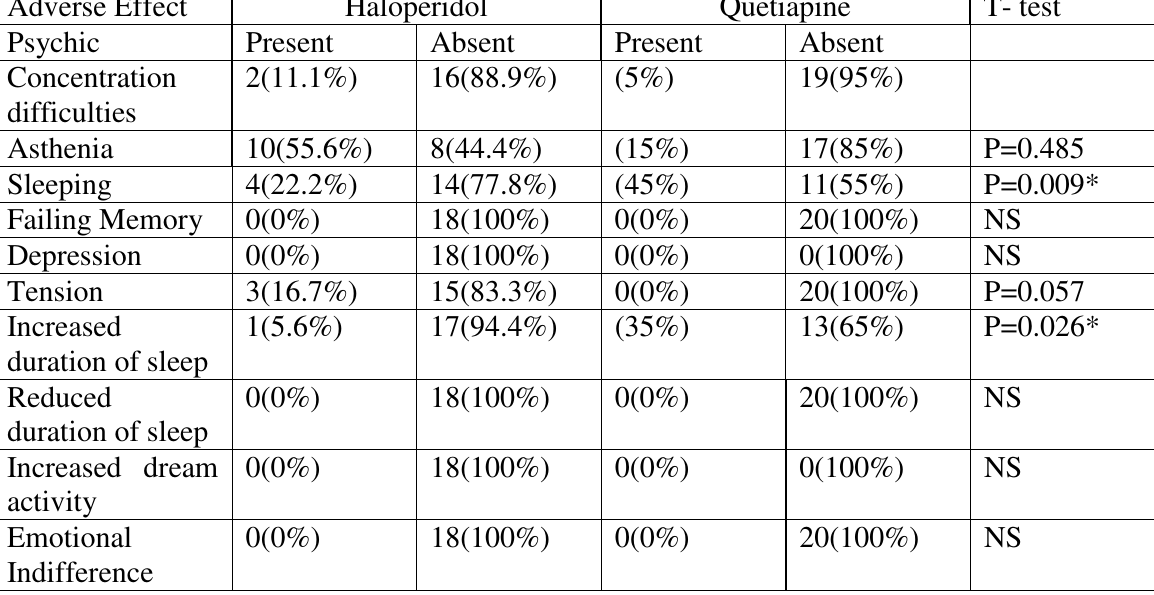
Table I: Psychic side-effects observed in both the groups during the study